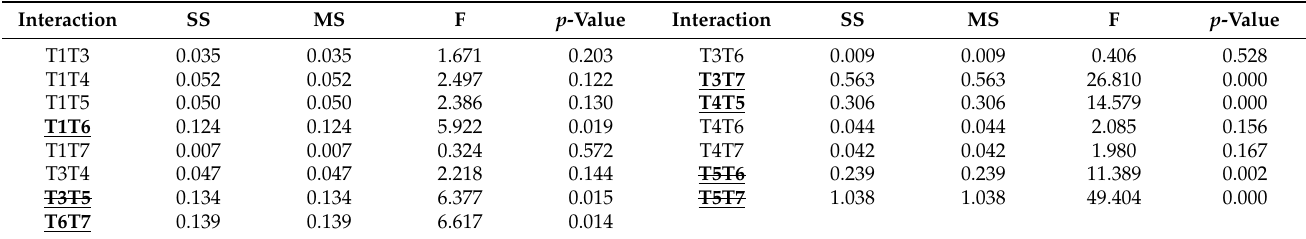
Table 12. Statistical significance of interaction between sandwich panel parameters. Statistically significant interactions are highlighted in bold and underlined. The omitted interactions are marked with a strikethrough.